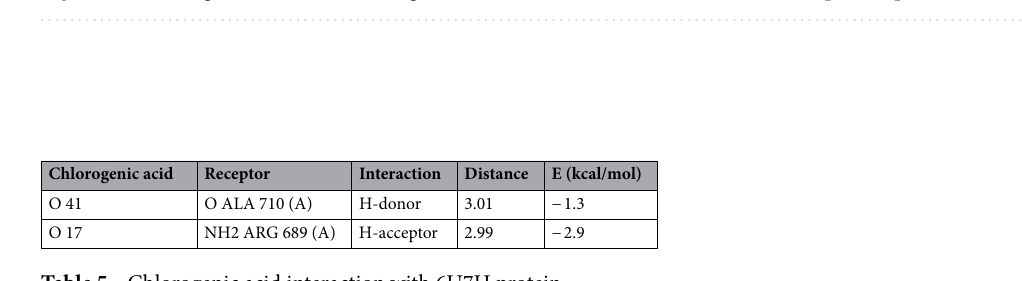
Figure 9. Docking interactions of chlorogenic acid and active sites of 6U7H and 1HZO protein proteins.